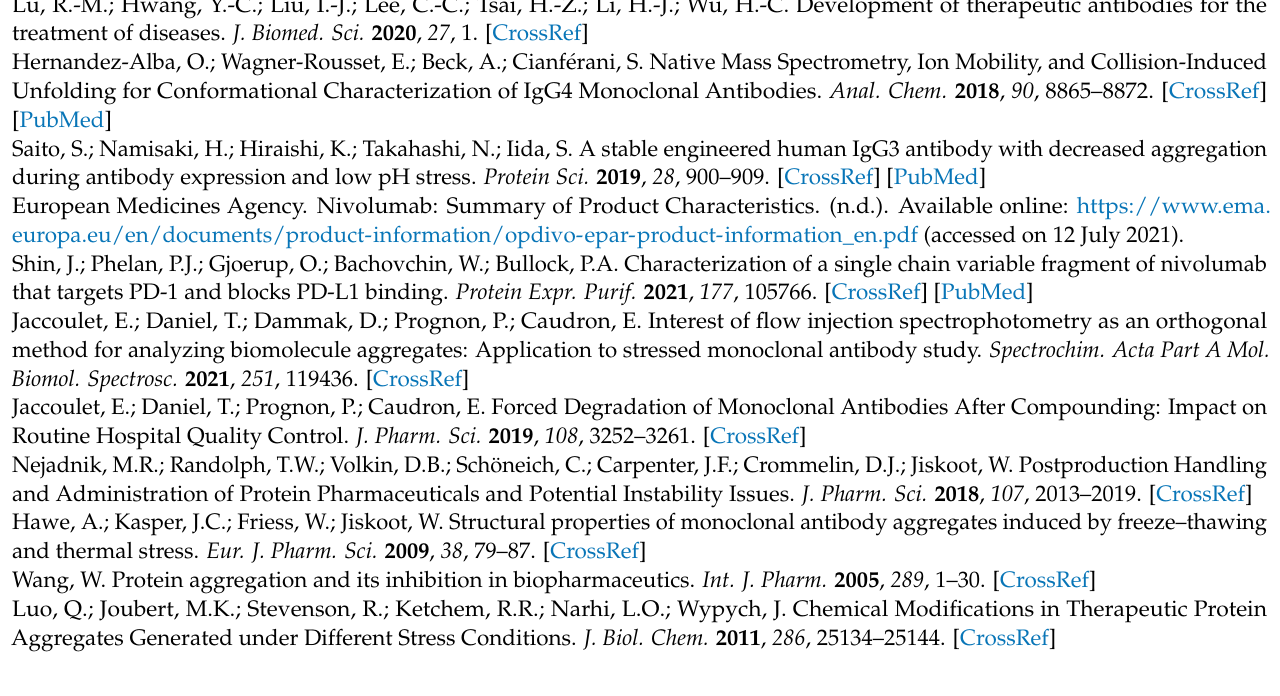
Figure S3: Experimental size exclusion column calibration model; Figure S4: Standard calibration curve for the ELISA